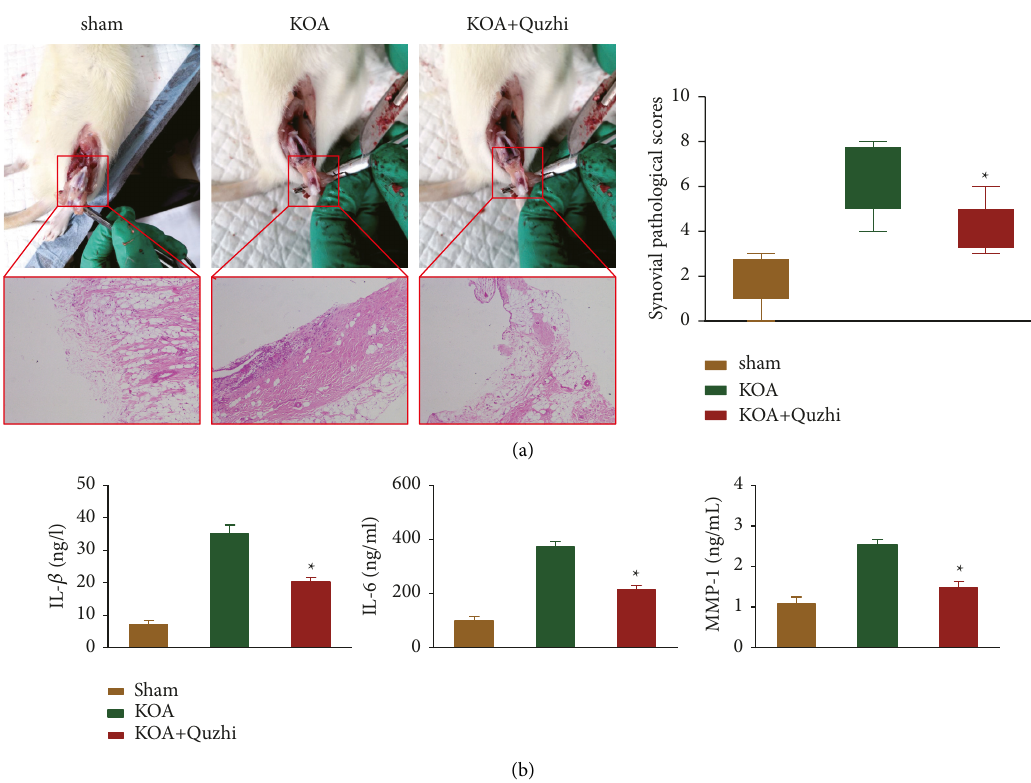
Figure 3: Quzhi decoction improves synovial inflammation in knee OA rats. (a) Representative images of histopathological HE staining of the synovium in rats are displayed ( × 200), and self-defined synovial pathological scores were calculated. (b) IL-1 β , IL-6 and MMP-1 serum concentrations were also calculated by immunoassay, and the results are expressed as the mean ± SEM. n � 8, ∗ p < 0 . 05. OA: osteoarthritis, IL: interleukin, MMP matrix: